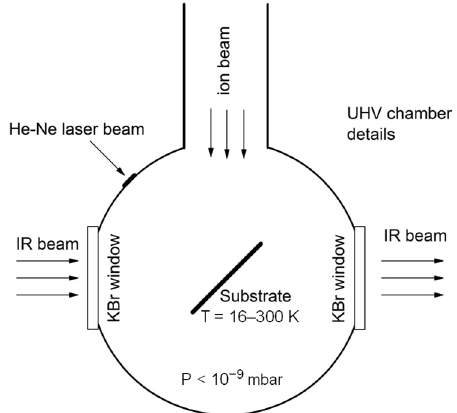
Figure 1. Simplified scheme of the apparatus for ion irradiation experiments. The corresponding dose is given in eV/16u. The stopping power changes with the ion mass and energy, hence different ions with different energy give the same chemical effects at the same irradiation dose even if the fluence can be different if they have different stopping power. By increasing the angle of incidence of ions from zero to 45 degrees, the stopping power increases since the penetration depth of ions decreases. Hence, irradiation at normal incidence would give the same effects of irradiation at 45 degrees of incidence, that is our configuration, at a slightly higher fluence. By using the TRIM Monte Carlo simu- lation software [42] and our PMMA film parameters, we observed that normal incidence irradiation would give the same dose at a 22% higher fluence with respect to 45 degree irradiation for 200 keV H + . At any rate, it should be considered that in space, for sufficiently long periods of time, irradiation occurs from all